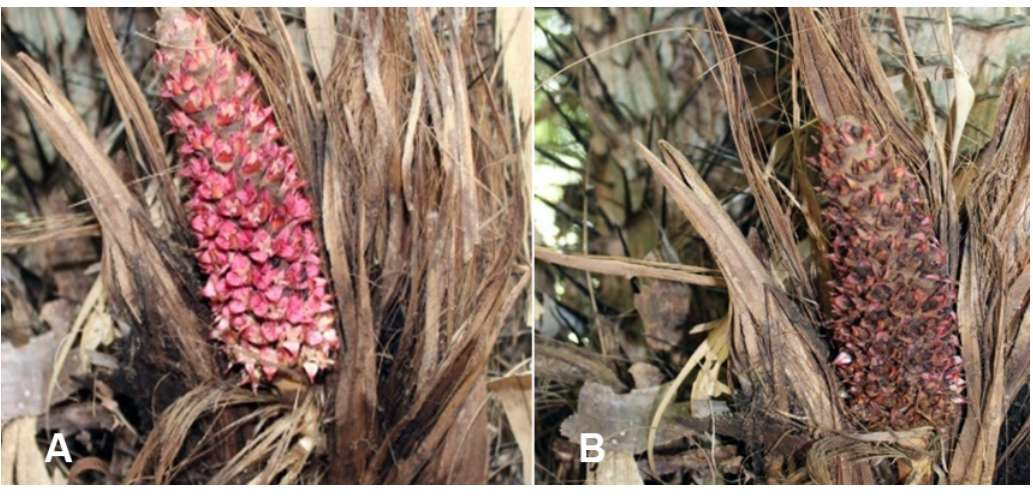
Figure 3 Panicle branches with hermaphrodite flowers of Sidimpuan snake fruit ( Salacca sumatrana Becc.) at anthesis ( A ) and post anthesis ( B ). Fibrous sheath removed to reveal